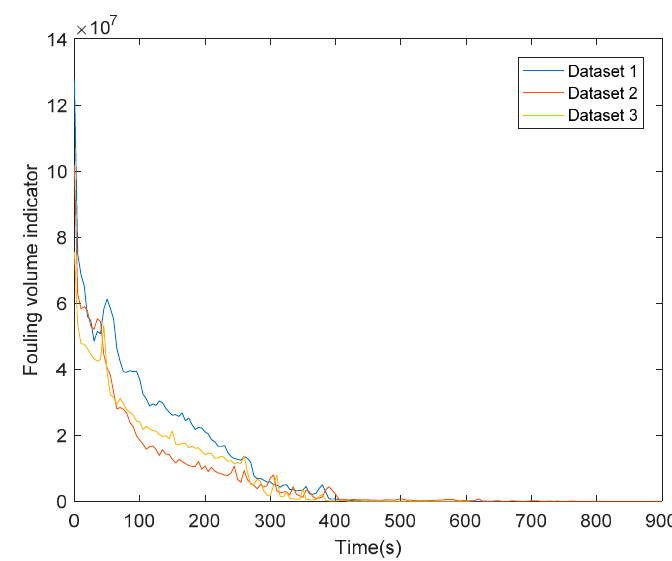
Figure 14. Fouling volume indicator chart.